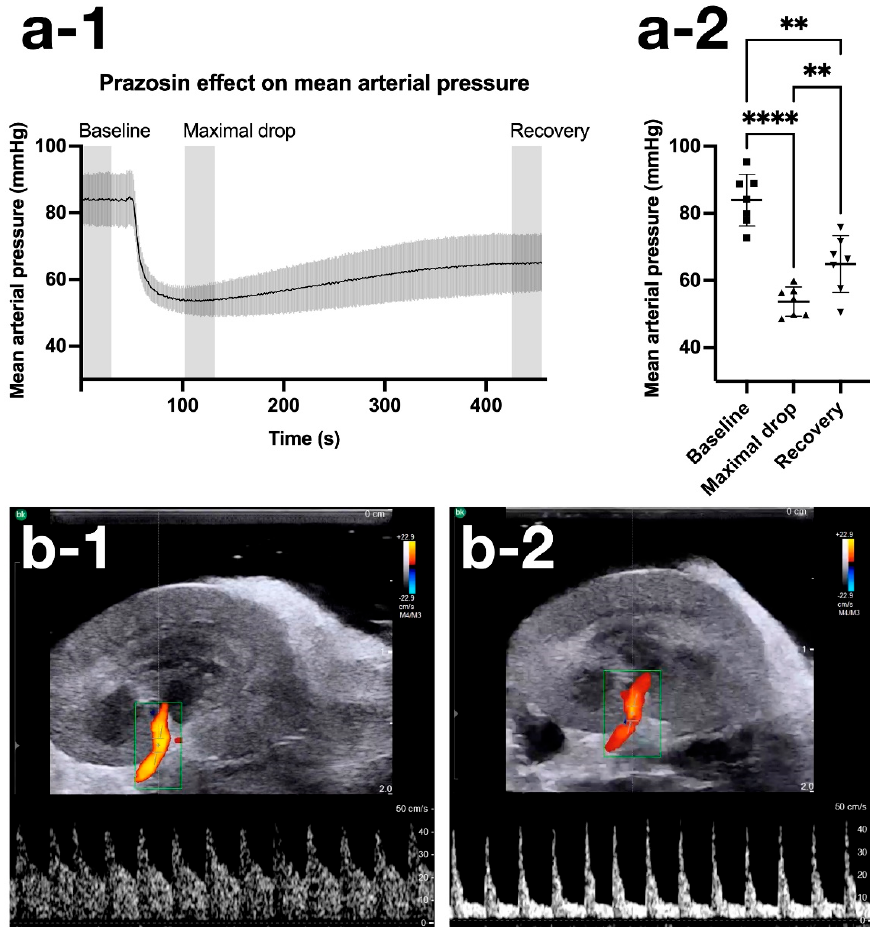
Figure 4. Effect of prazosin on mean arterial pressure and renal artery triplex Doppler. ( a-1 , a-2 ) show the effect of prazosin on mean arterial pressure during SRUS scan 2 (mean and standard deviation shown). ( b-1 ) shows an example of the color Doppler and spectral Doppler wave pattern from the normal renal artery or one of its branches at baseline before SRUS scan 1. ( b-2 ) shows a decreased color Doppler signal and altered spectral Doppler wave pattern from the same artery after completion of SRUS scan 3. ** = p ≤ 0.01, **** = p ≤ 0.0001.